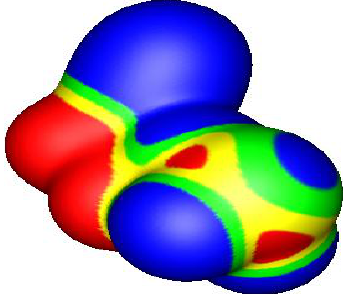
Figure 11. Electrostatic potential of 5,5-difluoro-4-oxa-5-phosphapentanenitrile [(NC)CH CH OPF ], computed at the B3PW91/6-31G(d,p) level on the molecular surface 2 2 2 defined by the 0.001 au contour of the electronic density. The phosphorus is toward the lower right, coming out of the page, the cyano group is toward the top, the fluorines are toward the bottom. Color ranges, in volts, are: red, greater than 0.65; yellow, from 0.65 to 0.35; green, from 0.35 to 0; blue, less than zero (negative). Two σ-holes are shown on the phosphorus in red, along the extensions of the O–P and F–P bonds. Their most positive values are: O–P, 0.95 V; F–P, 0.82 V.